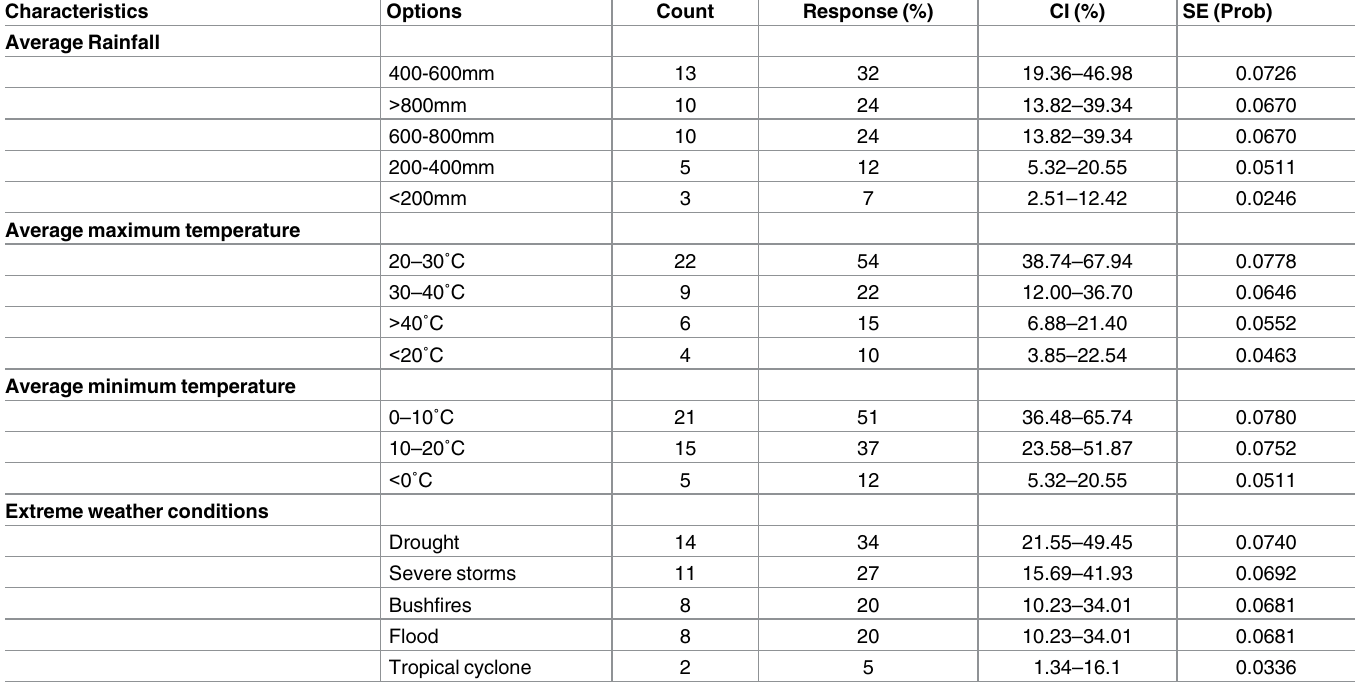
Table 3. Climatic conditions in the preceding year on respondent farms.